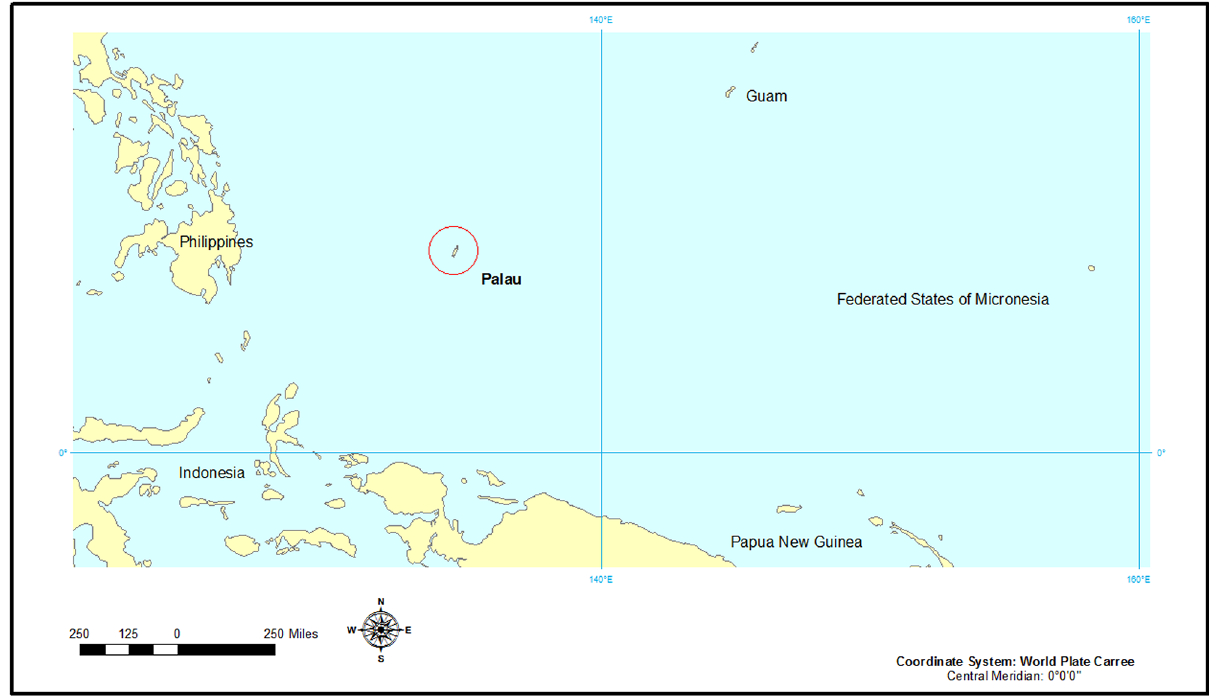
Fig 1. The archipelago of Palau, only 465 km 2 , occurs west of the Federated States of Micronesia (FSM), and southwest of the Guam and the Marianna Islands. Map created with ArcGIS, ArcMAP